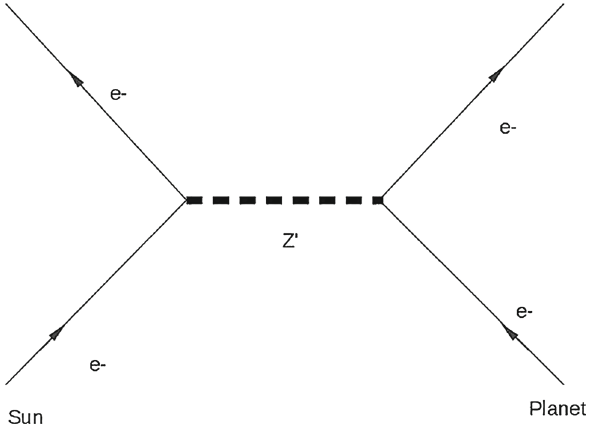
Fig. 1 Mediation of L e − L μ,τ vector gauge bosons between planet and